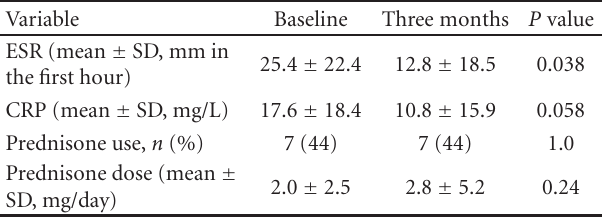
Table 1: Inflammatory markers, prednisone use/dose, and levels at baseline and at three months after starting anti-TNF